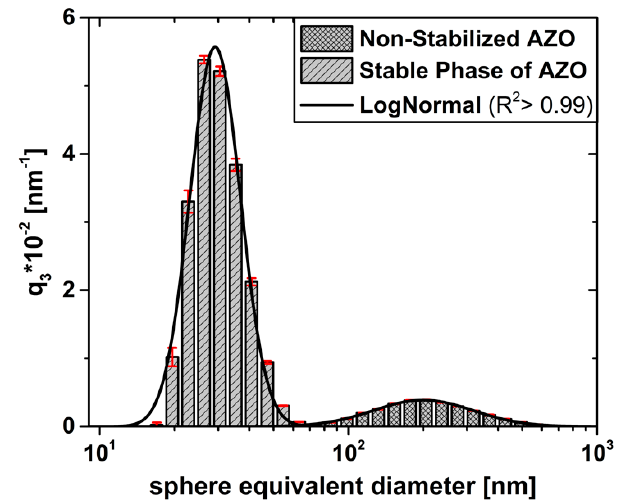
Figure 5. Volume-weighted size density distribution of the stable AZO phase (striped bars) is contrasted to the non-stabilized AZO dispersion (plaid bars) in Figure 2b, including the associated log-normal distributions (solid lines).